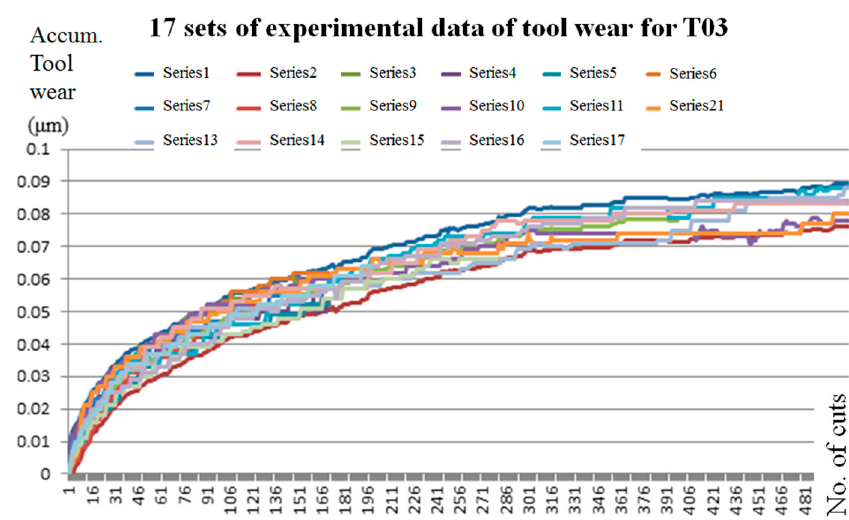
Figure 12. Statistics of tool wear for T03.